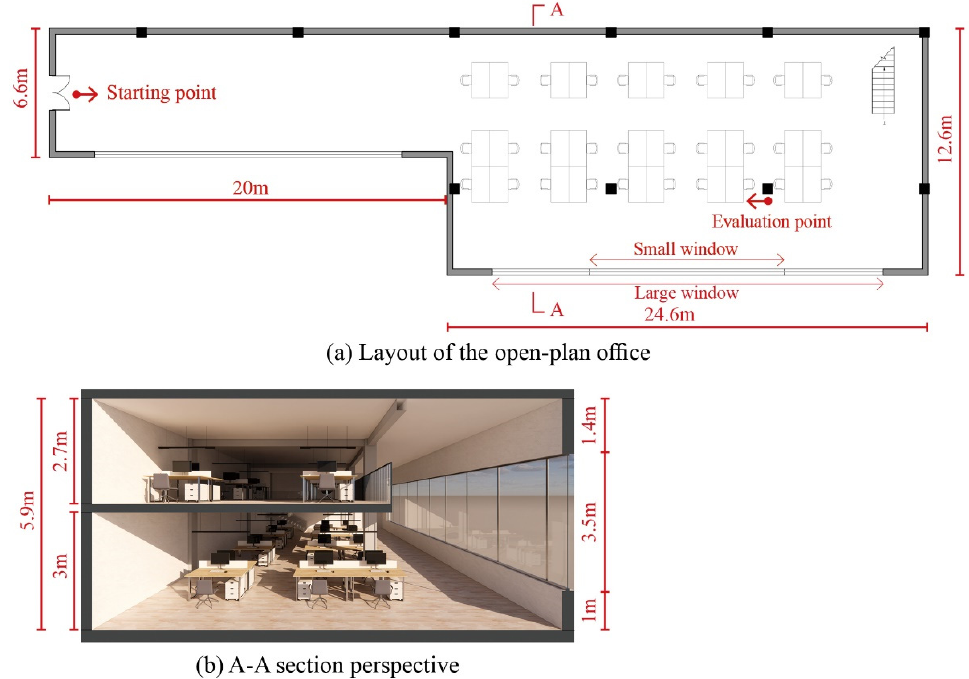
Figure 2. ( a ) Layout and ( b ) Section perspective of the open ‐ plan office.